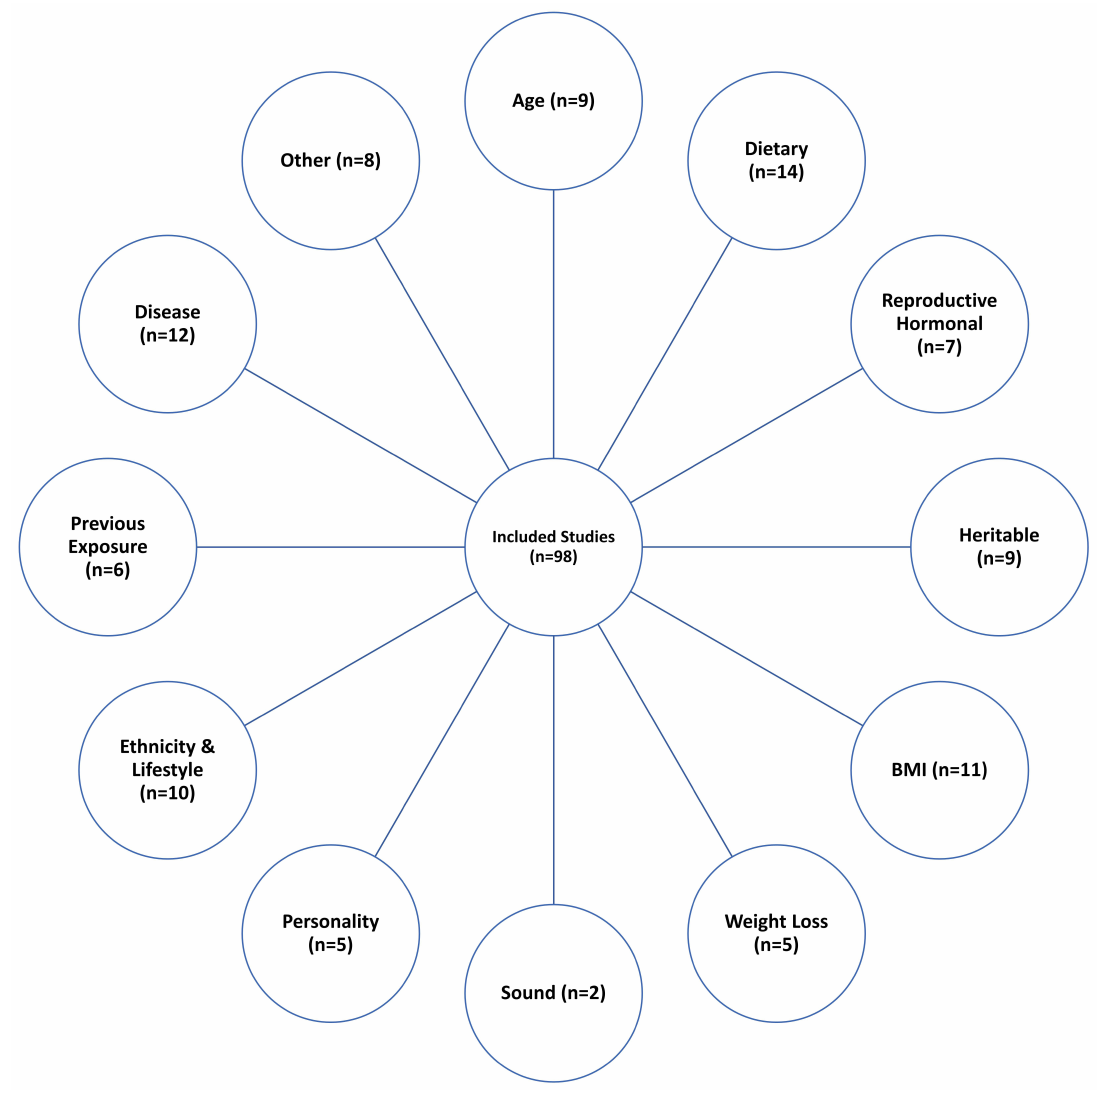
Figure 2. Sweetness preference distinct